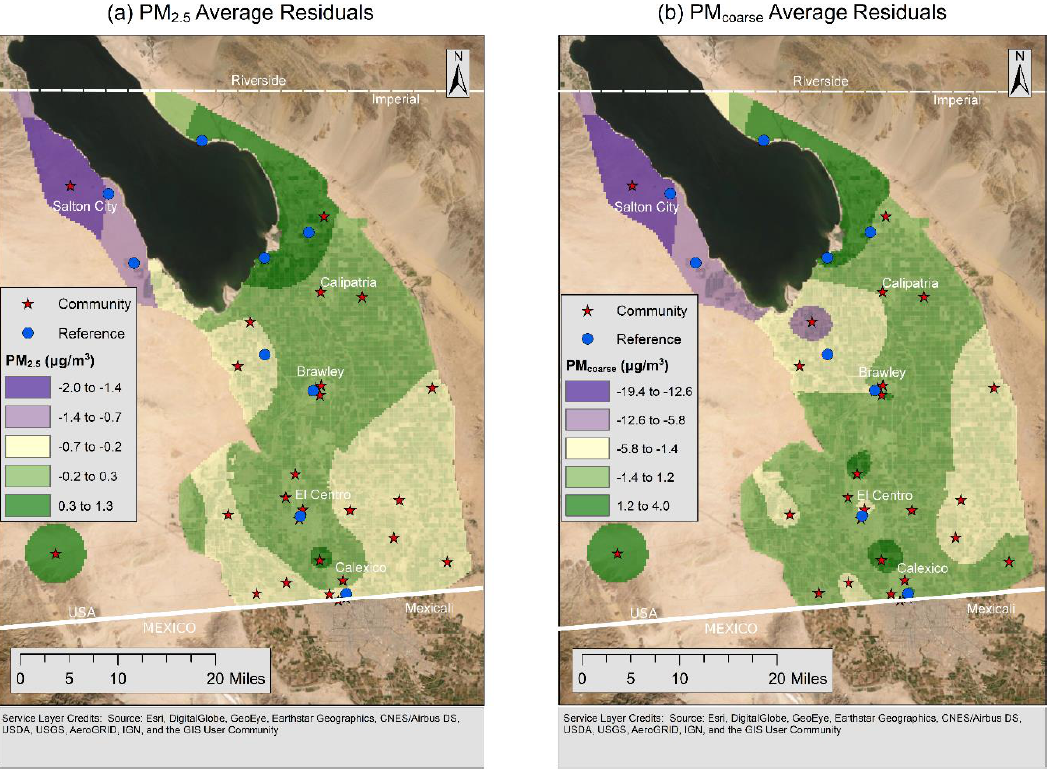
Figure 1. ( a ) PM 2.5 (particulate matter less than 2.5 μm in diameter) residuals; ( b ) PM coarse (difference between PM 10 and PM 2.5 ) residuals.